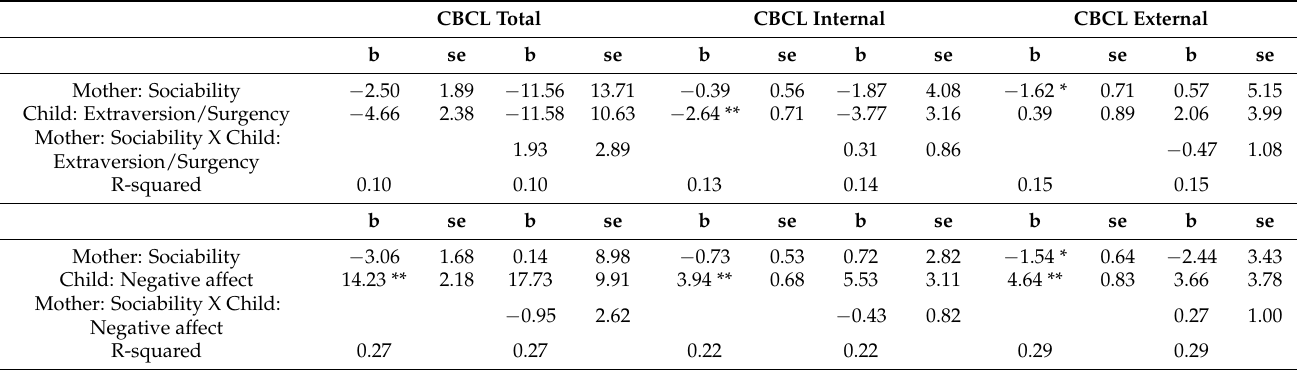
Table 5. The associations between maternal and child extraversion/surgency with child problem